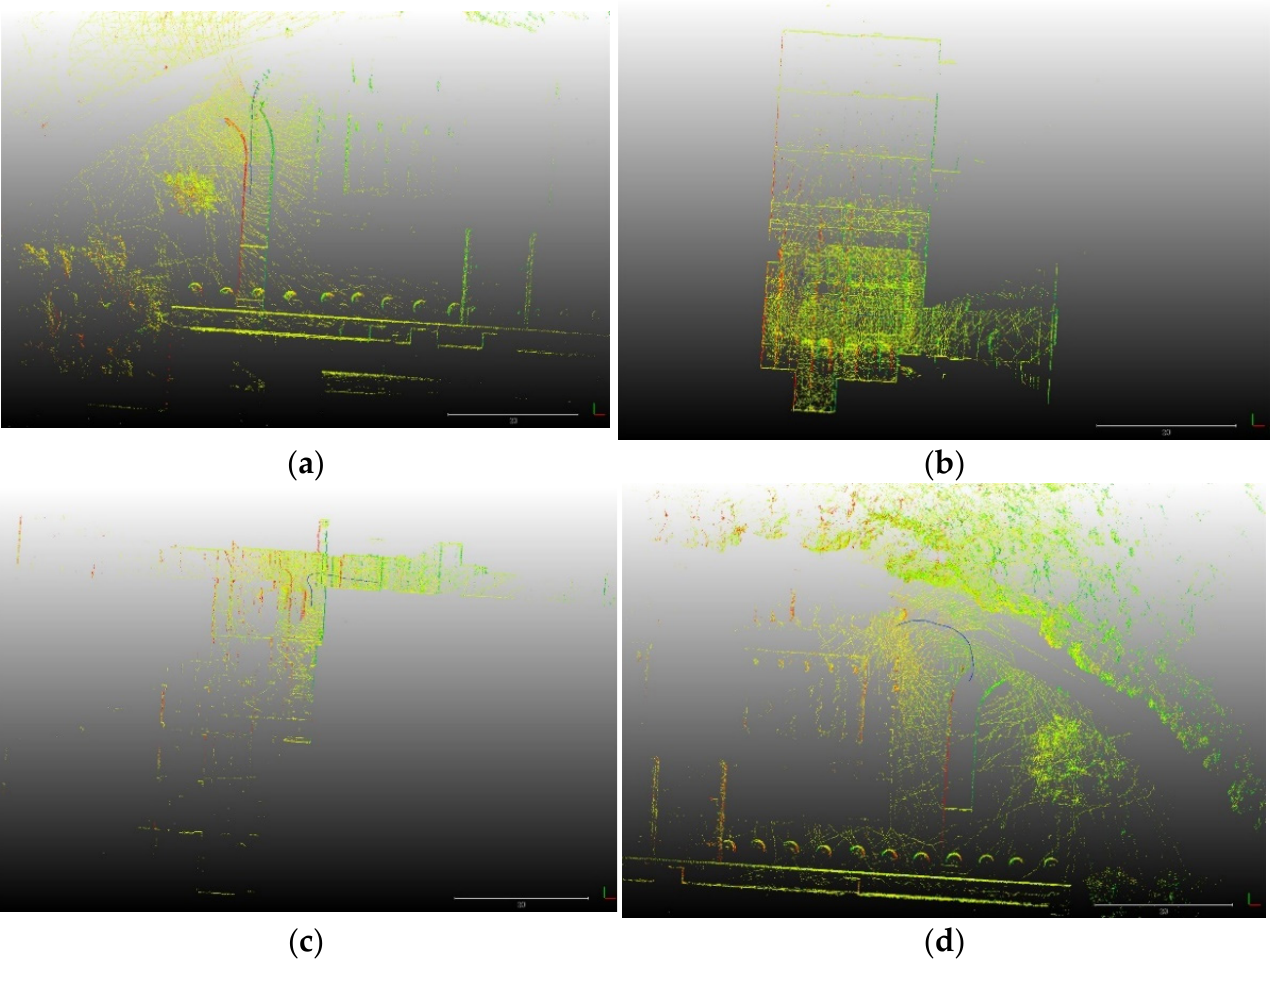
Figure 8. Four typical scenes for the parameter comparison experiment. ( a ) Indoor-outdoor transi- tional scene. ( b ) Open indoor scene. ( c ) Indoor scene in a narrow corridor. ( d ) Outdoor open scene. By setting different parameters, submaps and trajectories within different periods of time can be obtained. We evaluated the influence of different parameters by comparing the trajectory difference after submap registration. As shown in Figure 9a, the maximum influence of parameter g on the trajectory is approximately 1.5 cm. Therefore, our method is insensitive to the choice of point cloud density. When accuracy requirement is not high, the density of the point cloud can be reduced to increase calculation speed. To find the optimal setting of w , we select different window lengths for the IMU-LiDAR data fusion and obtain trajectories of different lengths. Taking the trajectory of the 80-frame window as a benchmark, we calculate the distance between trajectories of different window lengths and the benchmark, and the maximum difference is shown in Figure 9b. The trajectory error of different window lengths is stable within a certain parameter